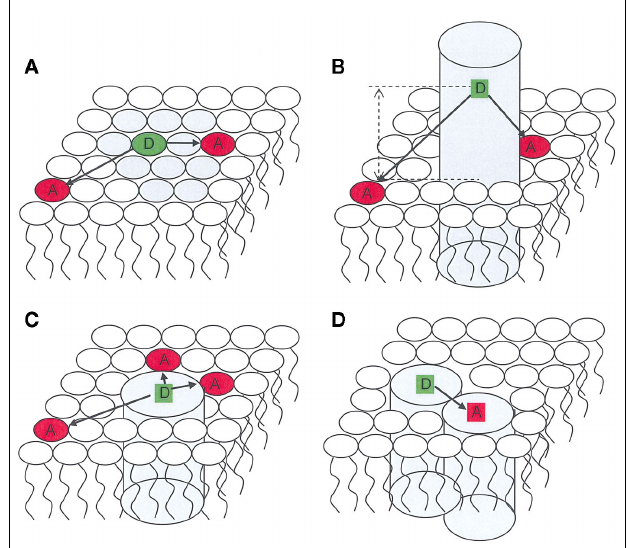
FIGURE 1 | Schematic representation of applications of FRET in membrane biophysics. Only one bilayer leaflet is depicted. (A) membrane heterogeneity; (B) determination of transverse location of a fluorescent residue/label; (C) protein/lipid selectivity; (D) protein oligomerization.